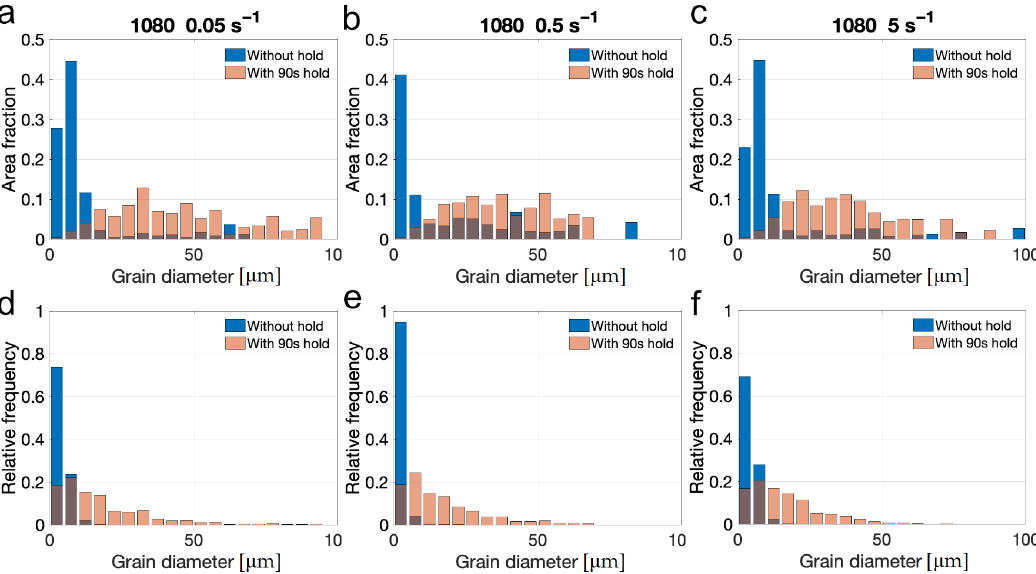
Figure 12. Grain size distribution for samples deformed at 1080 ◦ C. ( a – c ) area fraction, ( d – f ) relative (number) frequency. Diameter here refers to the equivalent circle diameter from EBSD. Please note that there are large grains falling outside the x -axis scale, see